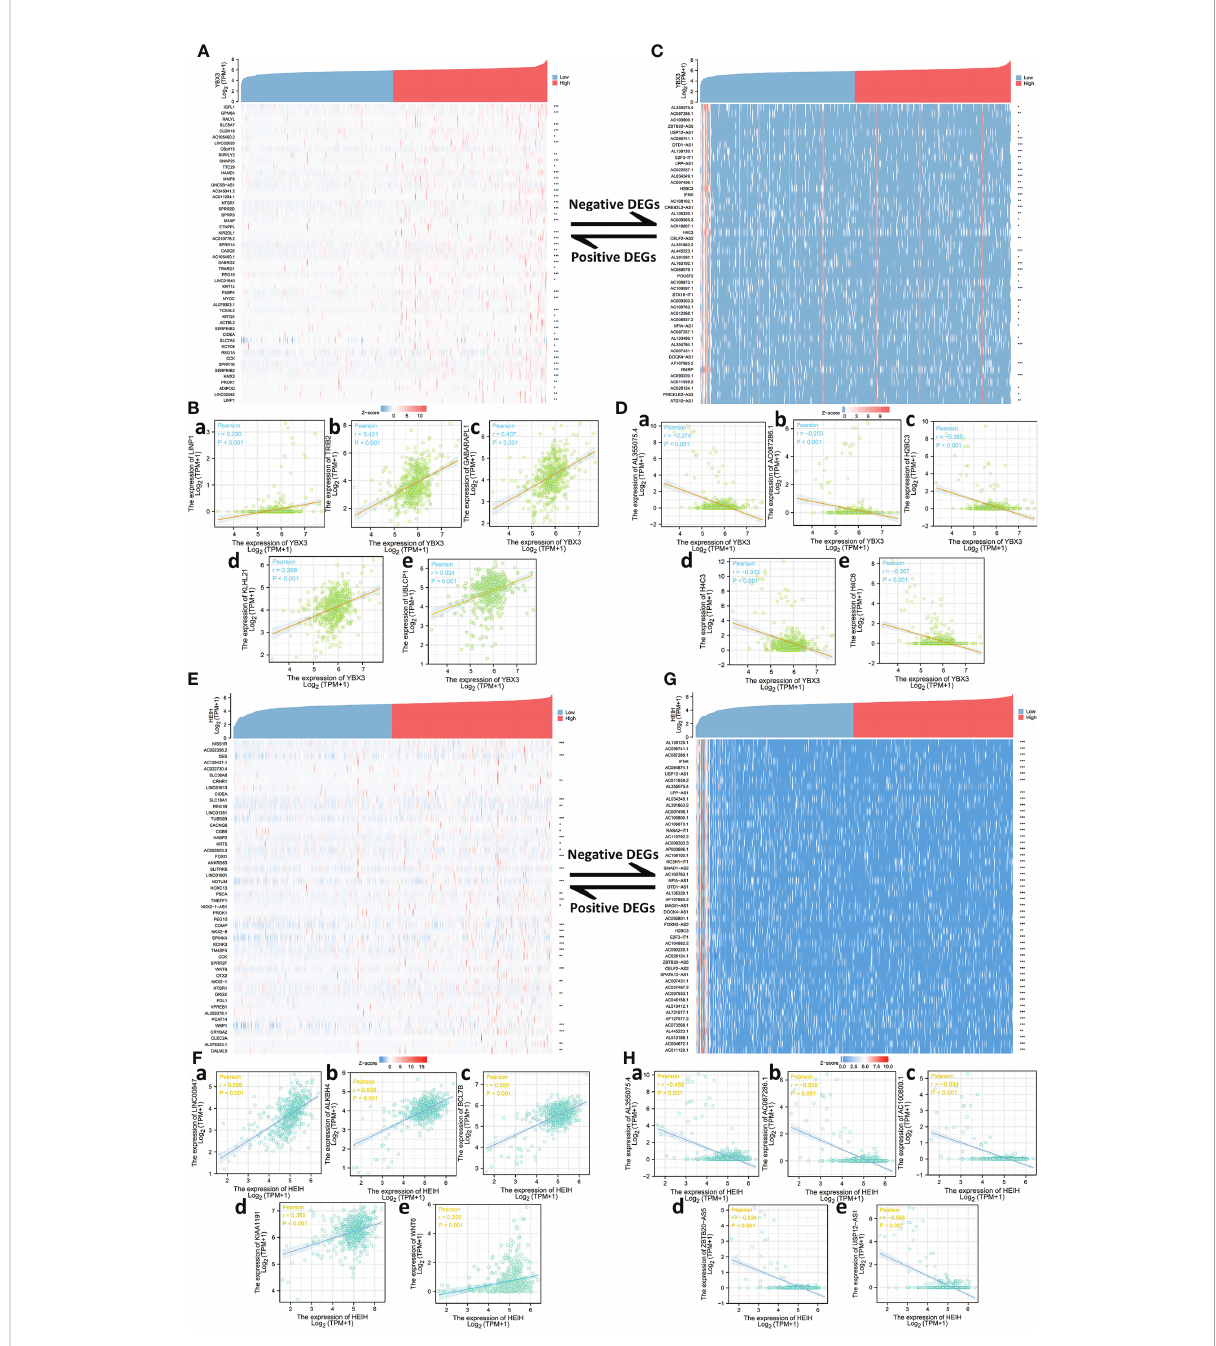
FIGURE 3 Top 50 genes correlated with YBX3 and HEIH expression in colon adenocarcinoma (COAD). (A) Gene co-expression heat map of the top 50 genes positively correlated with YBX3 in COAD. (B, a – e) Correlation analysis of the top fi ve genes and YBX3 expression of COAD (positively correlated). (C) Gene co-expression heat map of the top 50 genes negatively correlated with YBX3 in COAD. (D, a – e) Correlation analysis of the top fi ve genes and YBX3 expression of COAD (negatively correlated). (E) Gene co-expression heat map of the top 50 genes positively correlated with HEIH in COAD. (F, a – e) Correlation analysis of the top fi ve genes and HEIH expression of COAD (positively correlated). ( G ) Gene co- expression heat map of the top 50 genes negatively correlated with HEIH in COAD. (H, a – e) Correlation analysis of the top fi ve genes and HEIH expression of COAD (negatively